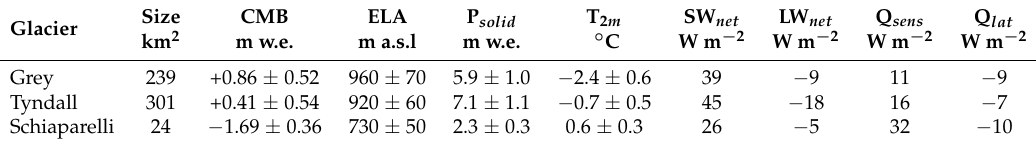
Table 2. Comparison of glacier characteristics and COSIPY/COSIMA results between the glaciers Grey (SPI), Tyndall (SPI), and Schiaparelli (MSM), averaged over the period 2000–2016. Listed are glacier size (km 2 ) and modeled annual glacier-wide mean CMB, ELA, P solid , T 2 m , SW net , LW net , Q sens , and Q lat . Size CMB ELA P solid T 2 m Glacier